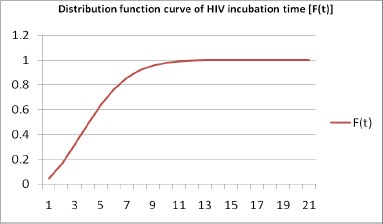
Weibull-2 distribution function probability of HIV incubation time (years)